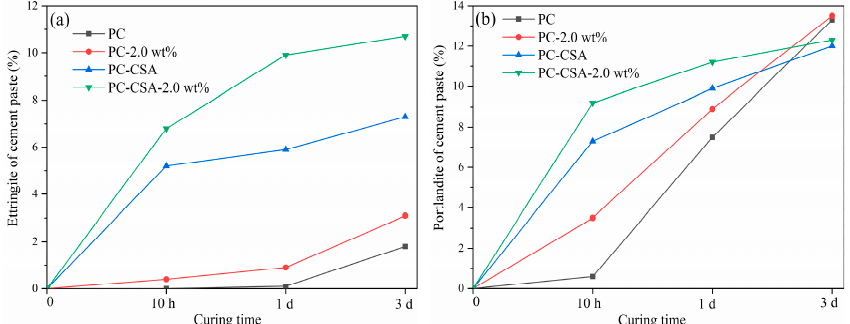
Figure 9. The content of hydrates in different binders at different curing times: ( a ) ettringite; ( b ) portlandite.